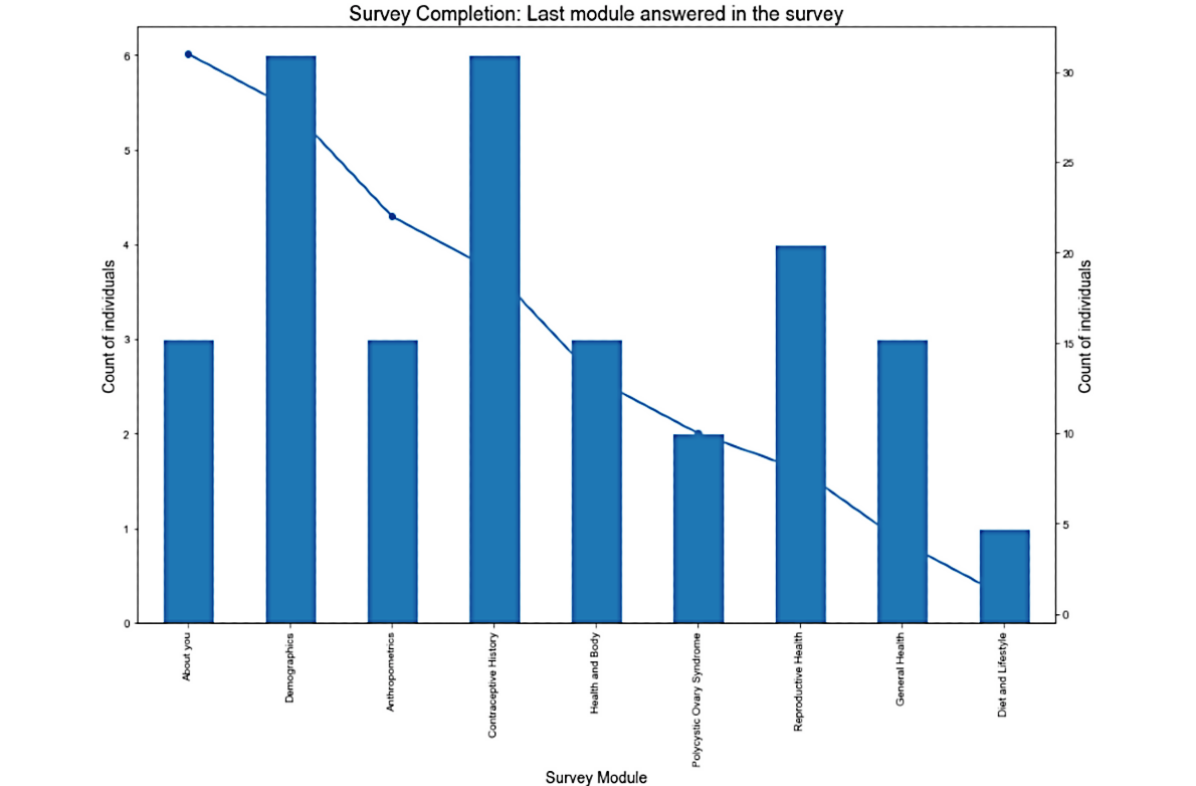
Figure 4. Survey completion by last module answered in the